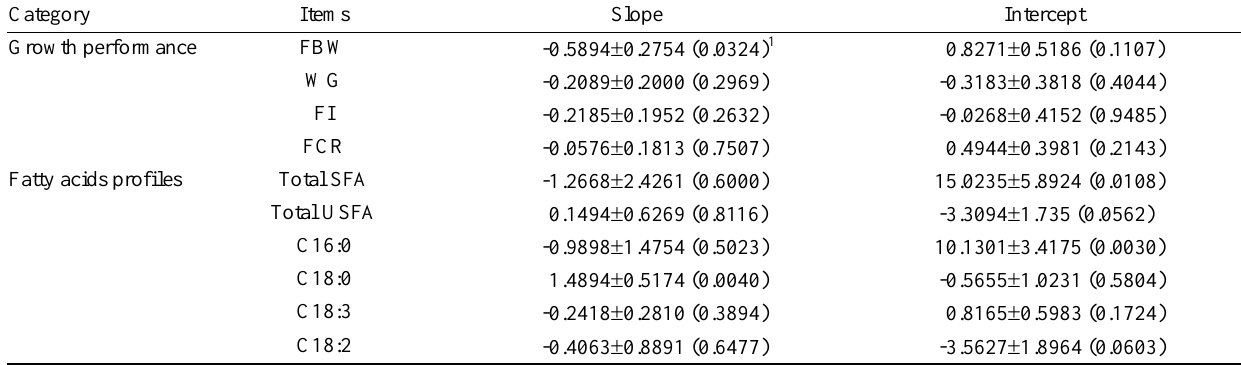
Table 4. Effect of CLA levels in diet on growth performance and fatty acids profiles in thigh of broiler chicken Category